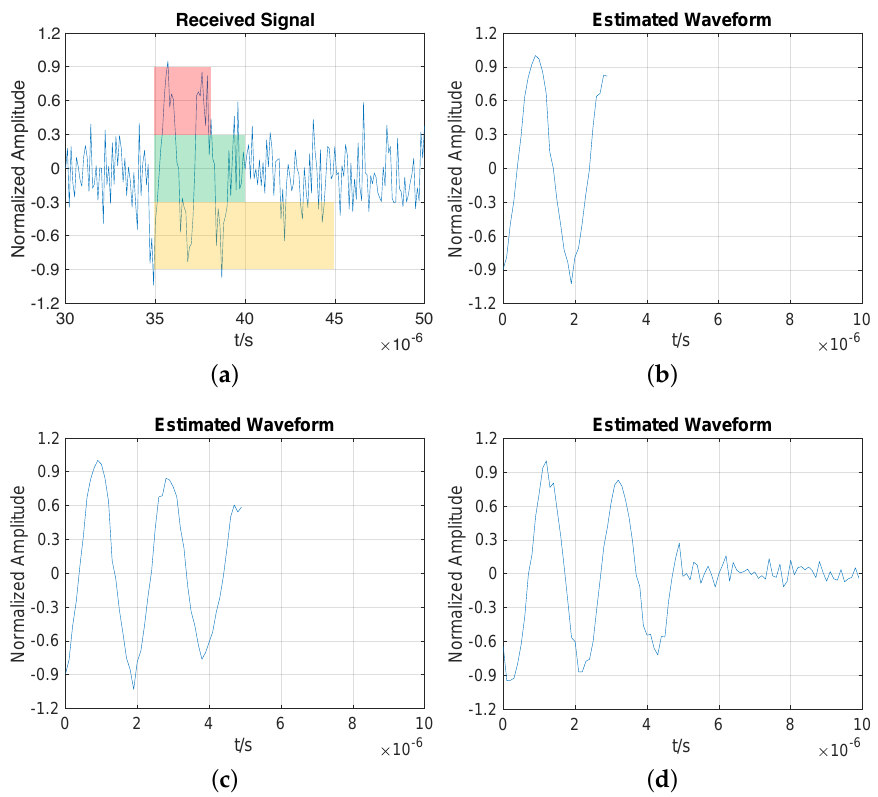
Figure 5. Illustration of a received signal and estimation results according to different inter- cepted pulse widths. ( a ) A diagram of three types of interception cases in single received pulse. ( b – d ) Estimated waveform corresponding to the following intercepted width of: ( b ) cases 1: 3 µ